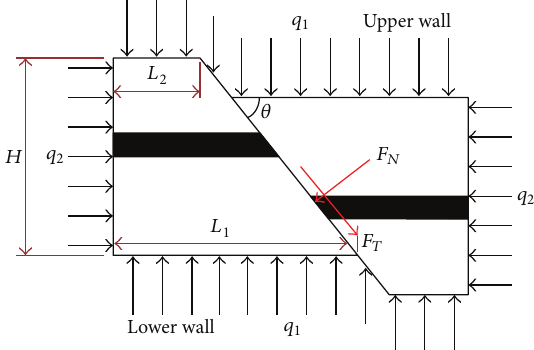
Figure 1: Mechanical model of the fault-slip.